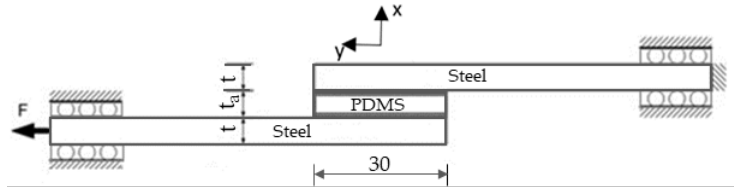
Figure 3. The specimen used in the simple shear test.